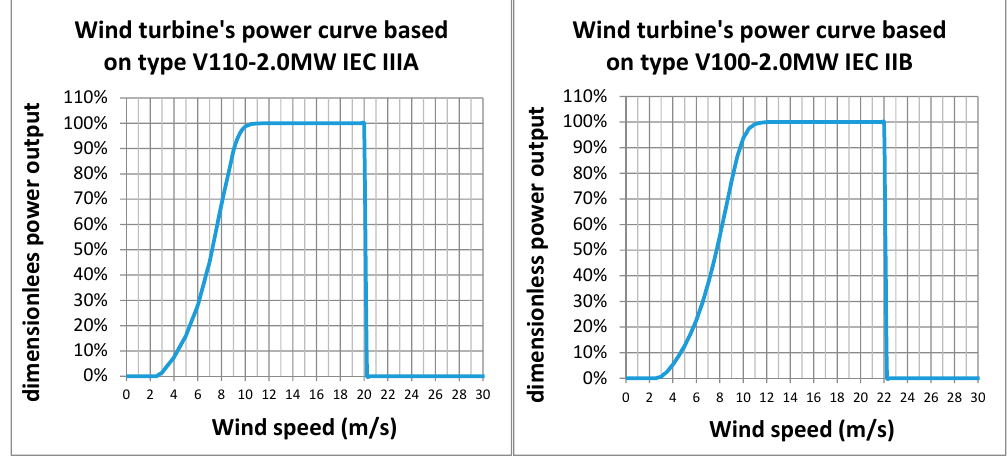
Figure 4. Dimensionless wind turbine’s power curves.